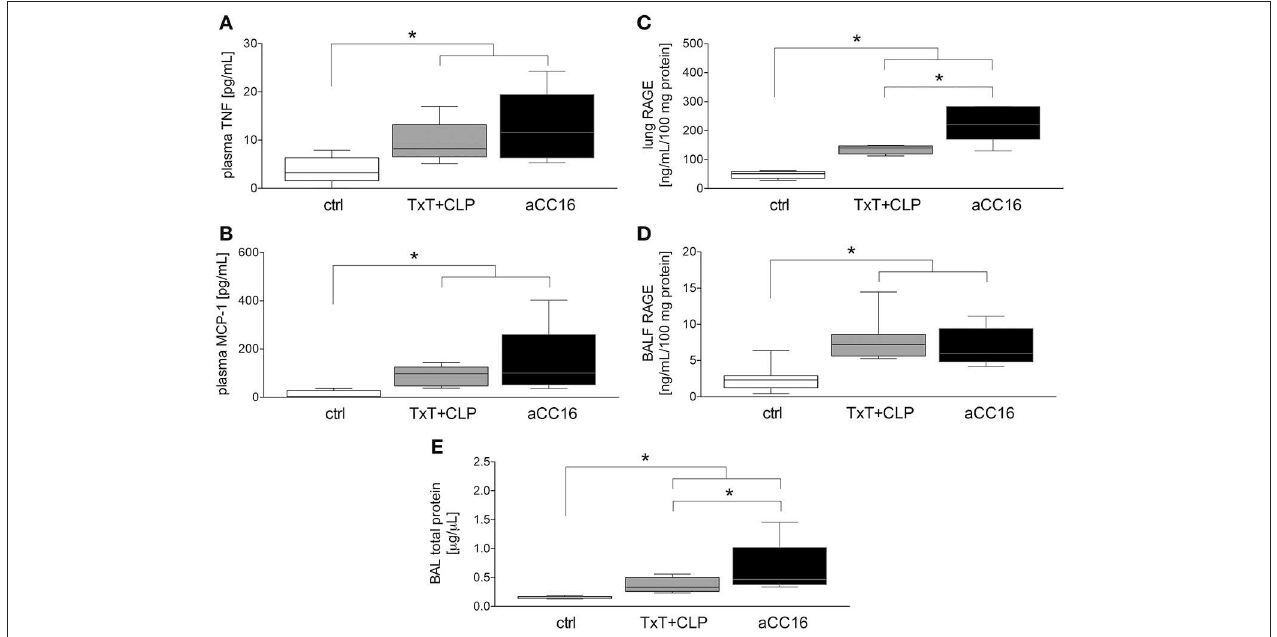
FIGURE 1 | Impact of CC16 neutralization on expression levels of pro-inflammatory mediators (A–D) and the total pulmonary protein amount (E) following thoracic trauma (TxT) with cecal ligation and puncture (CLP). Plasma levels of TNF (A) and MCP-1 (B) , and RAGE protein levels in lungs (C) and BALF (D) were measured. Total protein amount was determined in BALF. Data are represented as box-whisker plot and min to max, * p < 0.05 vs.